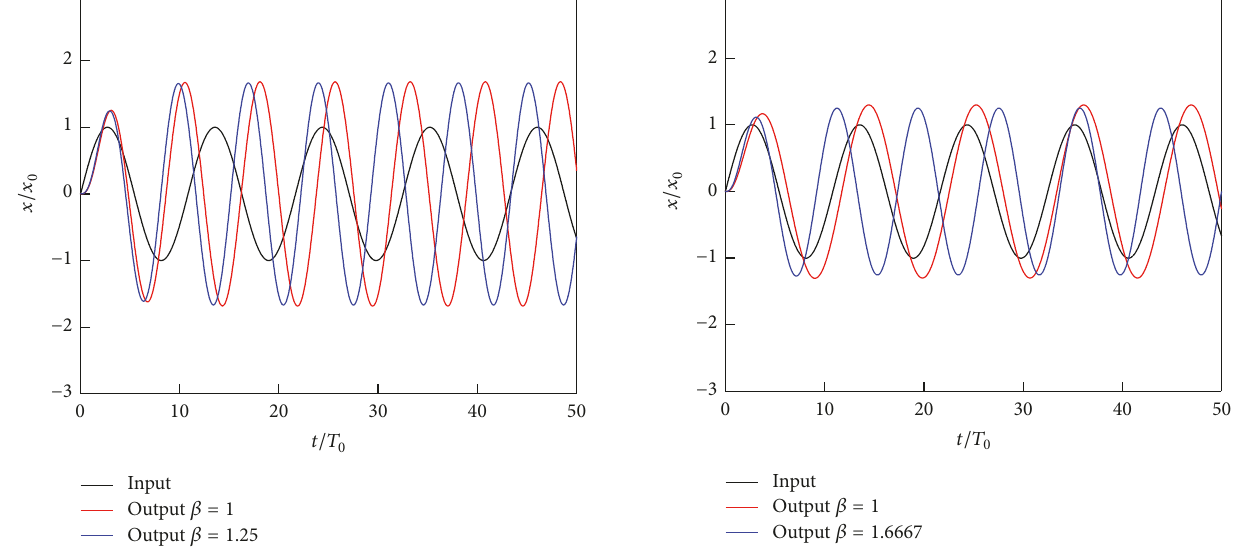
Figure 37: Response in the time domain ( 𝛼 = 2, 𝛽 = 1, 1.25 , at resonance frequency).